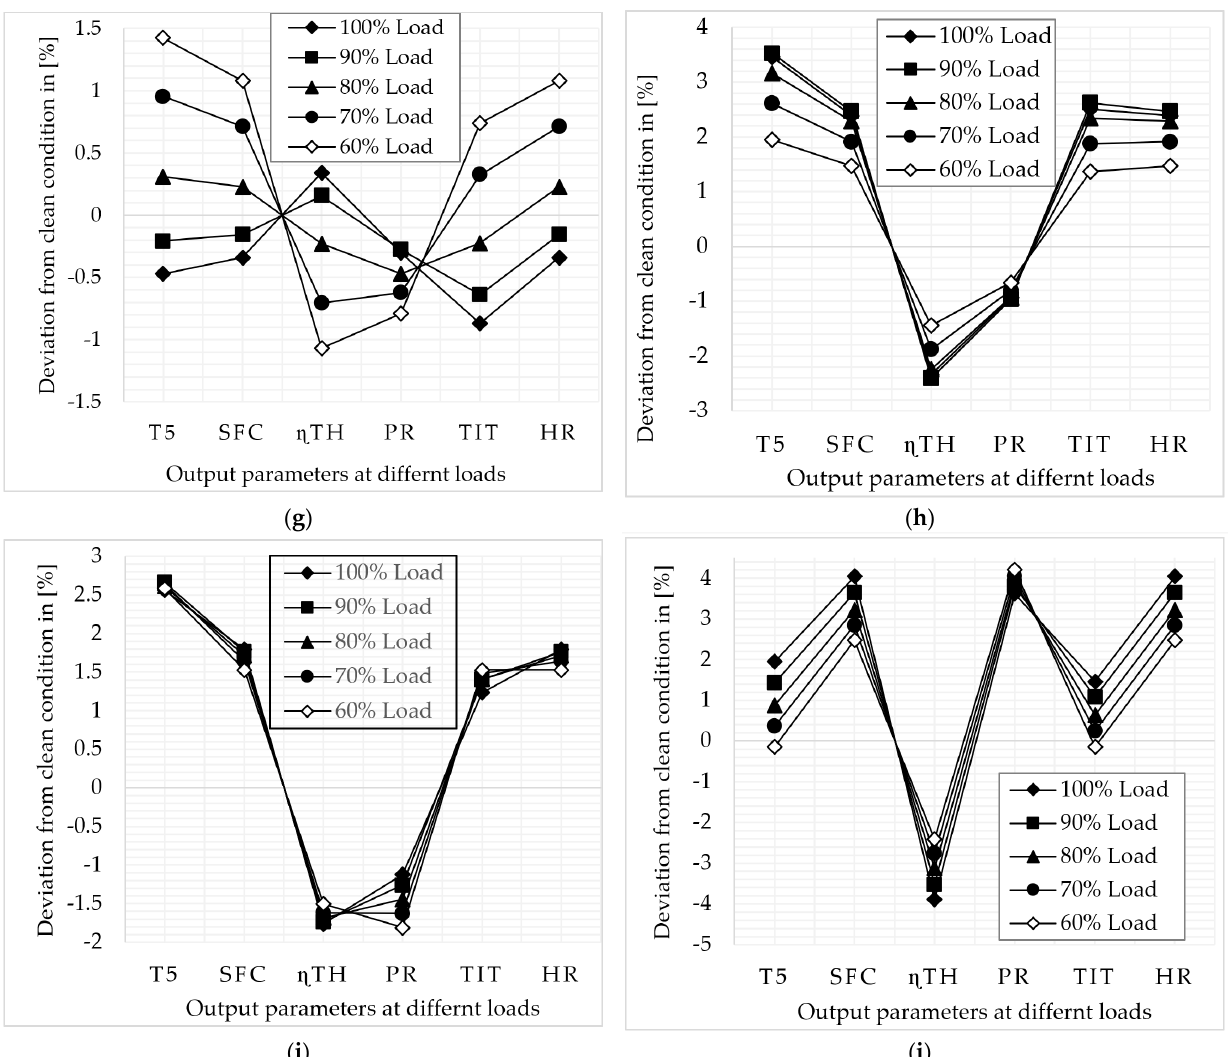
Figure 6. Deviation in output parameters due to physical faults at full − load and part − load operation: ( a ) LPC fouling at 100% fault severity, ( b ) LPC erosion at 100% fault severity, ( c ) HPC fouling at 100% fault severity, ( d ) HPC erosion at 100% fault severity, ( e ) HPT fouling at 100% fault severity, ( f ) HPT erosion at 100% fault severity, ( g ) LPT fouling at 100% fault severity, ( h ) LPT erosion at 100% fault severity, ( i ) PT fouling at 100% fault severity, ( j ) PT erosion at 100% fault severity.